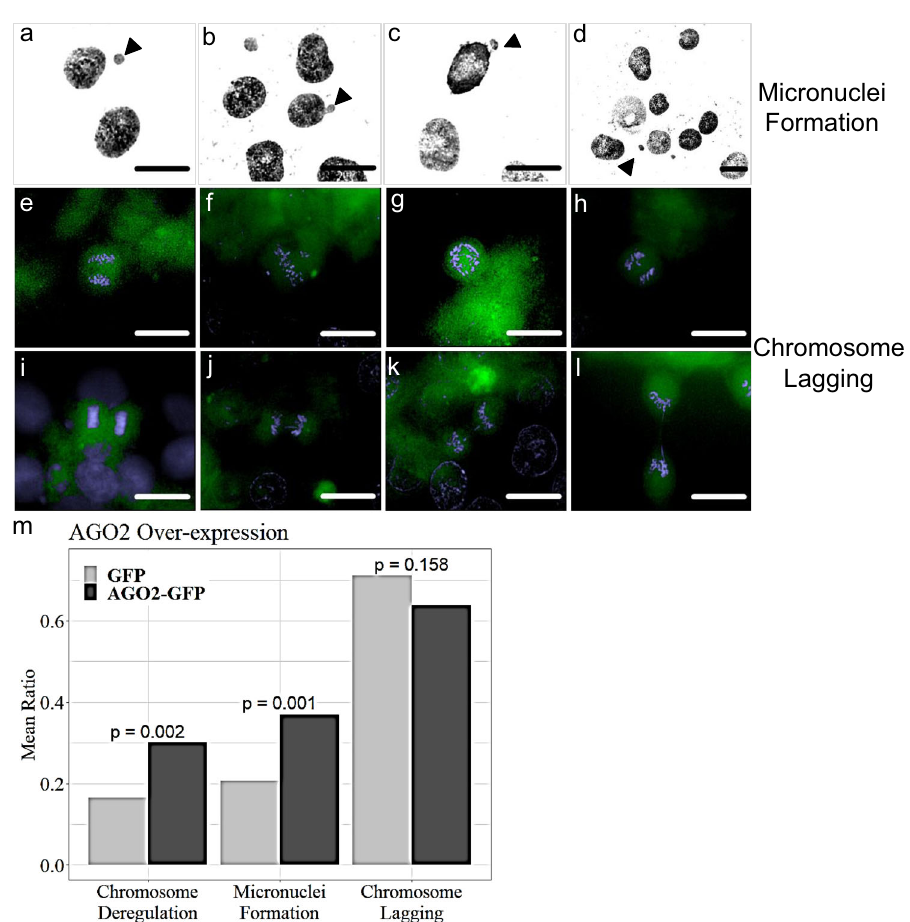
Fig. 7 AGO2 over-expression leads to numerical chromosomal instability and micronuclei formation. a – d Representative images of HCT116 AGO2-GFP transfected cells depicting a , c , d micronuclei formations and b bleb nuclei, as indicated by the black arrowheads. e , i normal anaphase and cytokinesis. AGO2-GFP transfected cells carry f abnormal metaphase congression, g anaphase or j cytokinetic chromosomal bridges, and h lagging chromosomes in telophase or k , l in cytokinesis. GFP expression in green and nuclei in blue (DAPI) (scale bar: 10 μ m). m Bar plot of the effects of AGO2 over-expression on numerical chromosome deregulation, micronuclei formation, and lagging chromosomes. z -test was used to evaluate their signi fi cance. Bar height indicates the ratio of deregulated chromosomes ( n = 3 biologically independent experiments, statistical sample size n 1 = 188 GFP cells, n 2 = 182 AGO2-GFP cells), cells with micronuclei formation ( n = 3 biologically independent experiments, statistical sample size n 1 = 174 GFP cells, n 2 = 168 AGO2-GFP cells), and with lagging chromosomes ( n = 3 biologically independent experiments, statistical sample size n 1 = 176 GFP cells, n 2 = 169 AGO2-GFP cells),